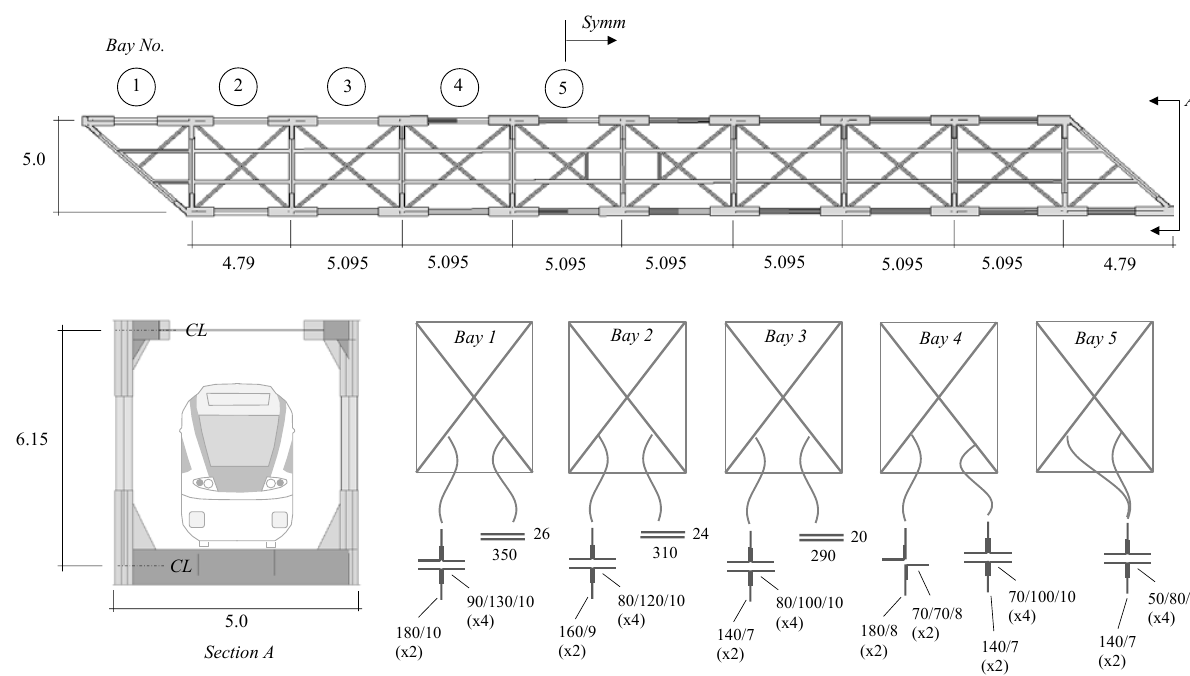
Figure 1. Münchenstein railway bridge basic